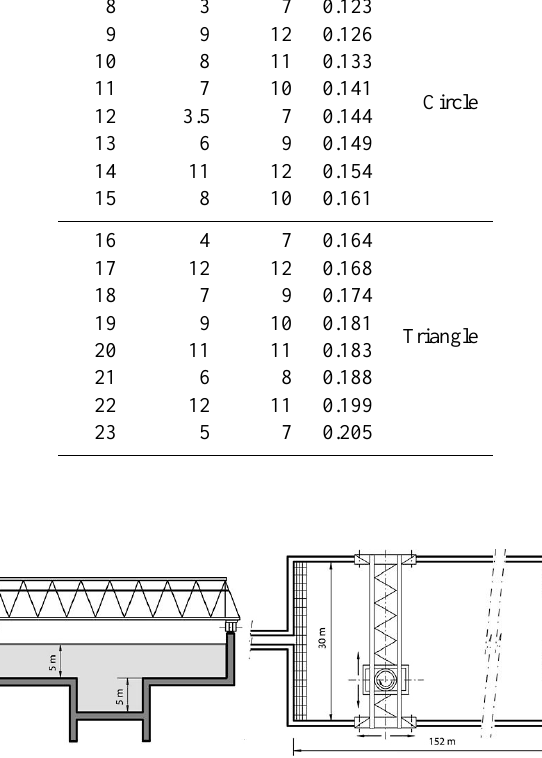
1 : 40. The waves generated for this study are long-crested and are registered by six capacitance wave gauges situated in the midline of the basin. Each experiment with the same initial conditions is carried out two times. For the second ex- periment, the gauges are moved 10 m downstream and repeat the same realization. The detailed gauge locations are listed in Table